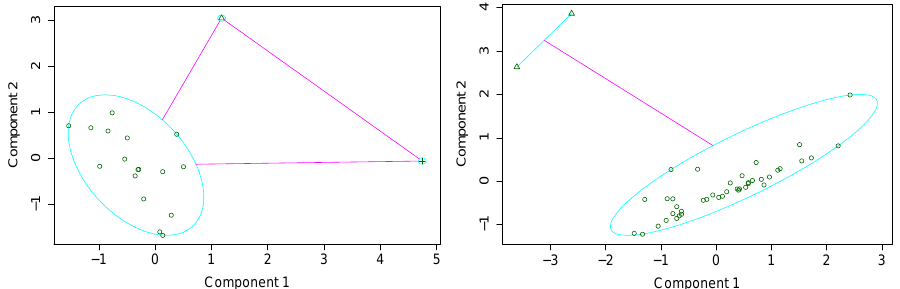
Figure 10. Similar to the right panel of Figure 9. The left panel shows PAM clustering with the three parameters being τ lag,i , Mag, and β Band , while the outliers are GRBs 080319B and 081221A. The right panel shows PAM clustering with the three parameters being τ lag,i , Age, and A V , while the outliers are GRB 980425B and 030528A.